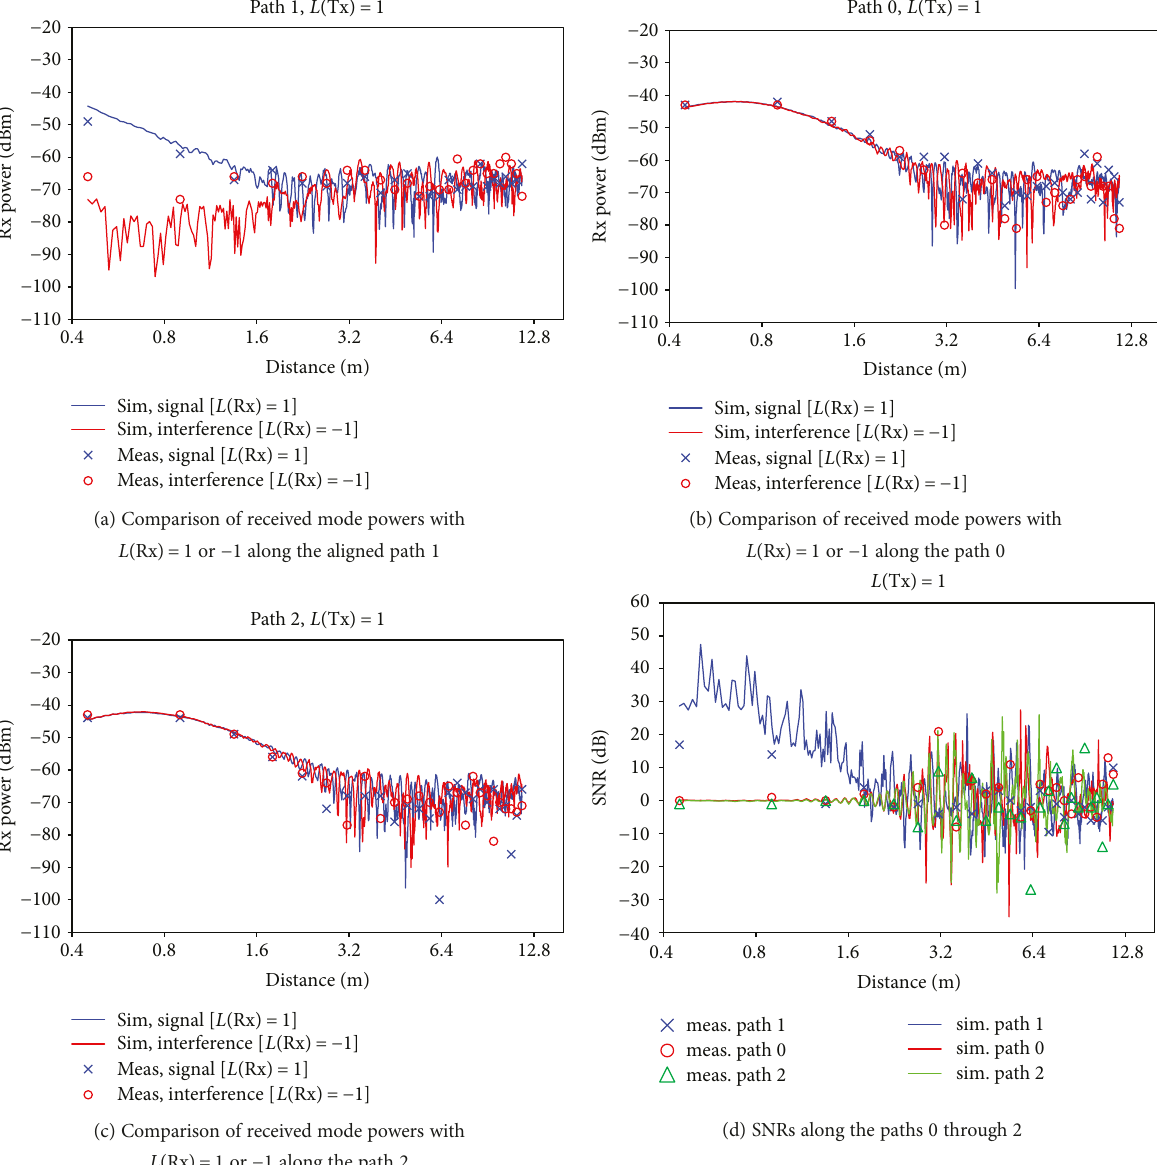
Figure 4: Received OAM mode powers along three paths in the lecture room for the transmitting mode of L